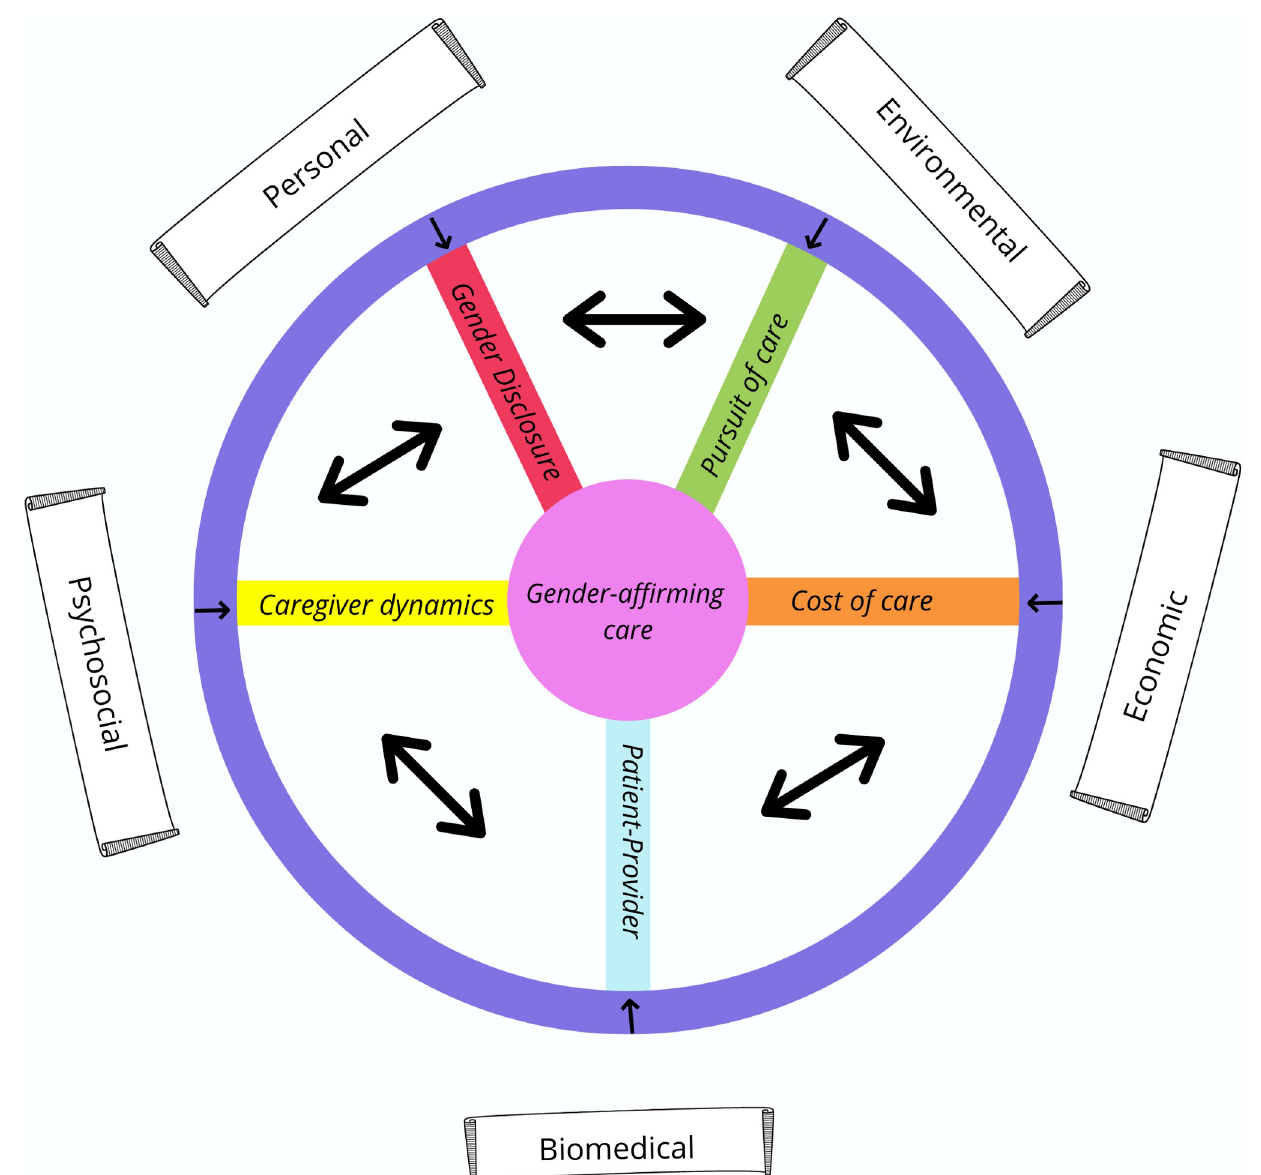
Fig 3. The rainbow brick road